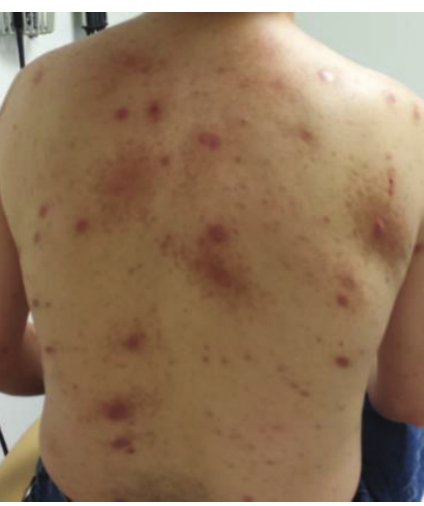
Figure 4: Photograph of the patient’s back upon completion of treatment with doxycycline. Note dramatic improvement in lesions with few persistent areas of discoloration.